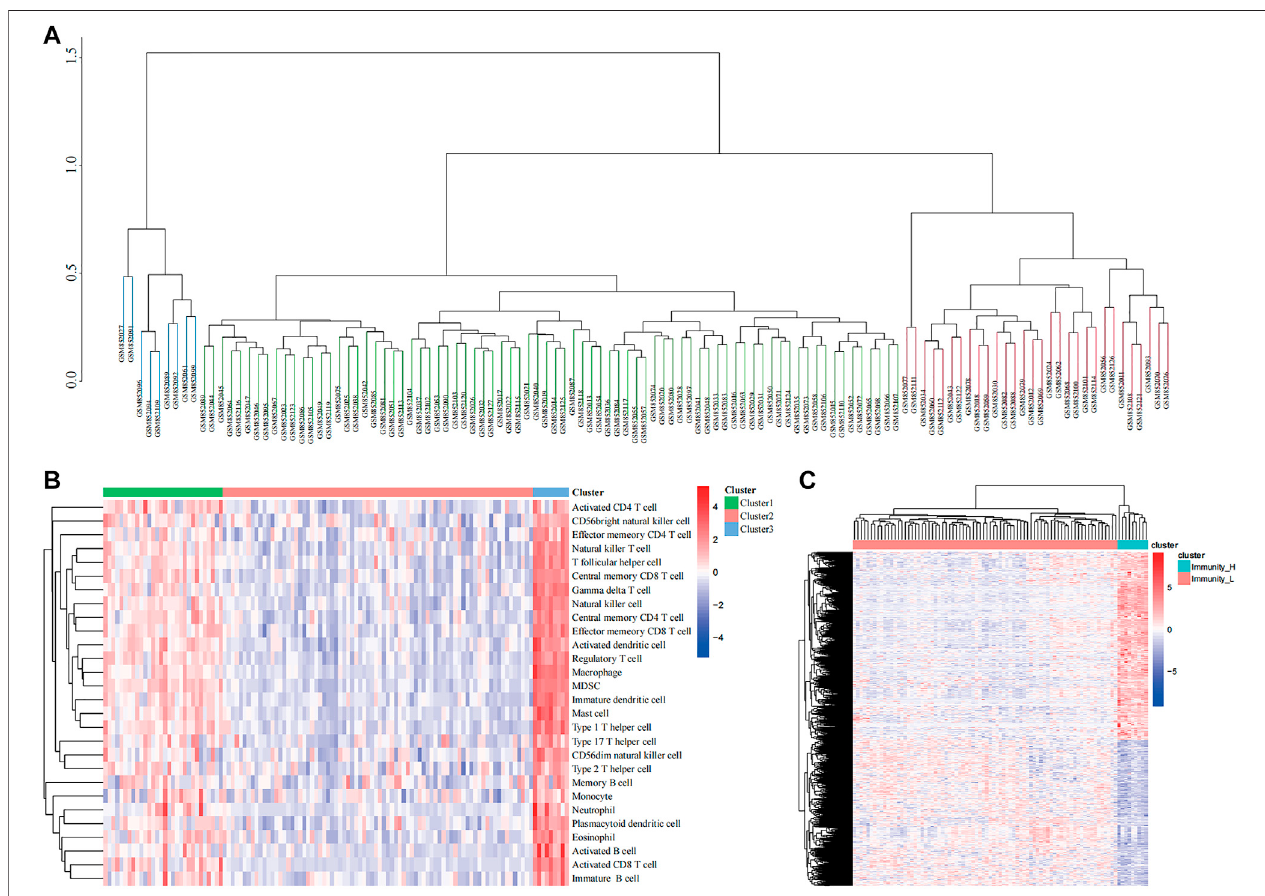
FIGURE1| Clusteringbasedon immune microenvironment inEwingsarcoma (ES). (A) Thesamplesweredivided intothreegroups based onsingle-sample Gene Set Enrichment Analysis (ssGSEA) immune scoring. (B) The enrichment levels of 28 immune-related cells in the high immune cell in fi ltration group (Immunity_H), middle immune cell in fi ltration group (Immunity_M), and the low immune cell in fi ltration group (Immunity_L). (C) Heatmap showing the difference between Immunity_H and